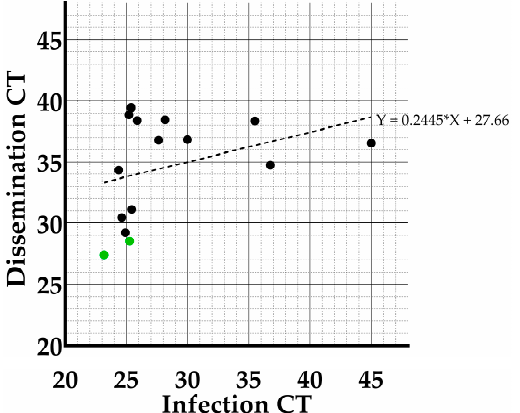
Figure 5. Graph showing the correlation between CT-values for infection and dissemination in Culex pipiens at the constant 25 ◦ C temperature condition implemented during incubation. Green dots indicate individual mosquitoes which tested positive in